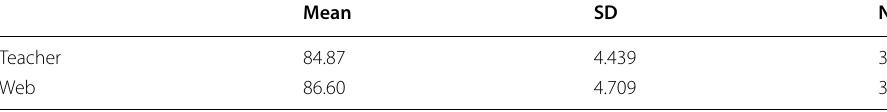
Table 4 Summary of Scores from the Instructor and Aim Writing